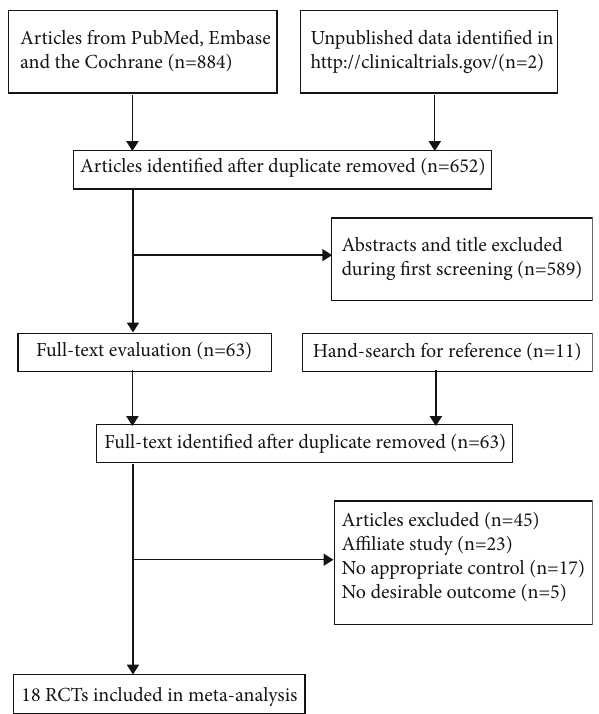
Figure 1: The PRISMA fl owchart for the literature search and study